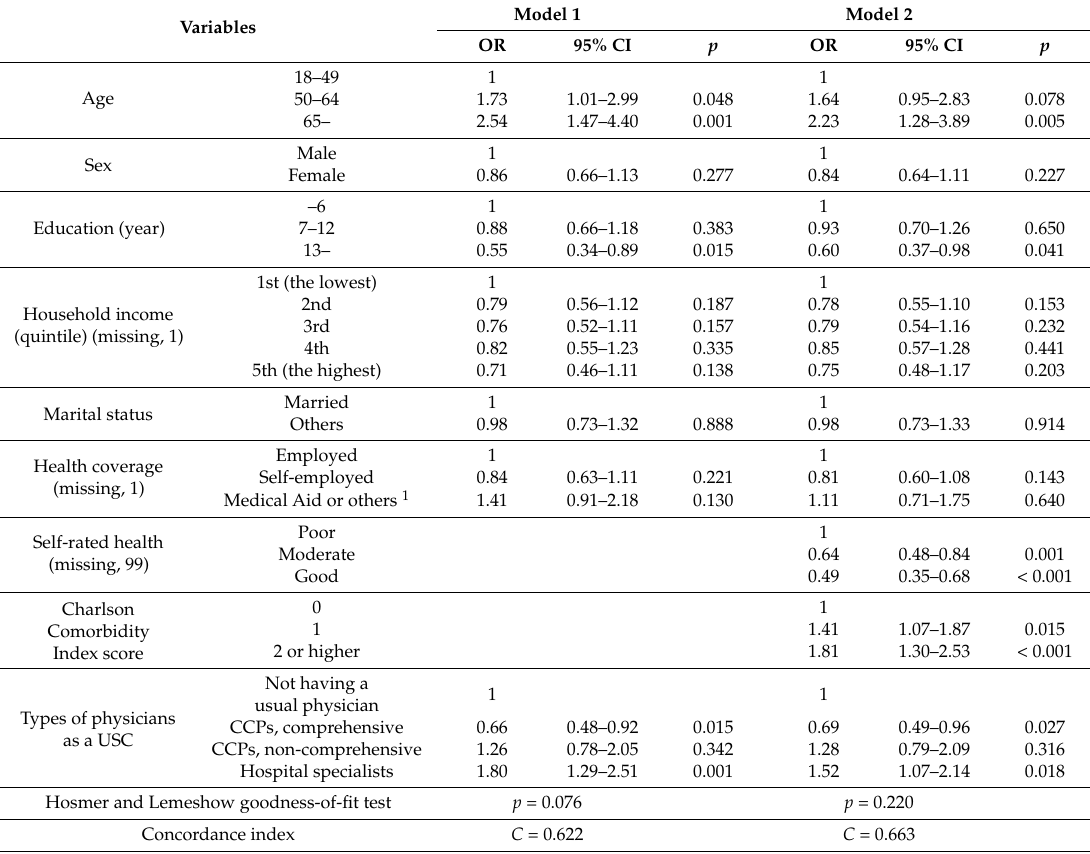
Table 4. Association between having a comprehensive CCP as a usual source of care and the experience of hospitalization within a year in adults ( ≥ 18 years) with hypertension—based on the 2013 Korea Health Panel